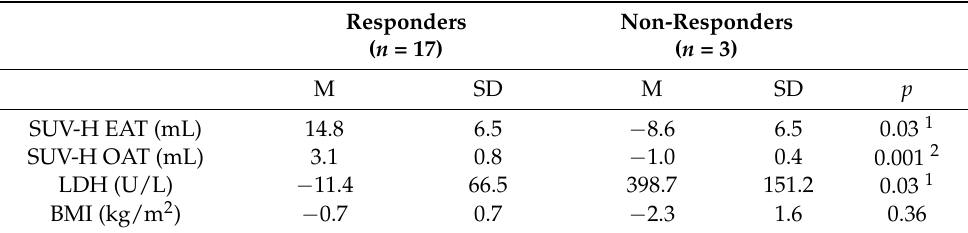
Table 2. Delta SUV-H EAT and SUV-H OAT volumes, serum LDH levels, and BMI with different treatment responses. Responders Figure 4. Delta SUV-H EAT, OAT volumes, serum LDH levels, and BMI with different treatment responses. ( a ) Greater delta SUV-H EAT volume was observed in responders than in non-respond- ers ( p = 0.03). ( b ) There was significantly more delta SUV-H OAT volume detected in responders than in non-responders ( p = 0.001). ( c ) A significantly higher delta LDH level was noted in non- responders than in responders ( p = 0.03). ( d ) There was no significant difference in delta BMI be- tween responders and non-responders ( p = 0.36). * Differences are significant at the 0.05 level (two- tailed). ** Differences are significant at the 0.01 level (two-tailed). SUV-H EAT, high standardized uptake value epicardial adipose tissue; SUV-H OAT, high standardized uptake value orbital adi- pose tissue; LDH, lactate dehydrogenase; BMI, body mass index; CR, complete response; PR, partial response; PD, progressive disease.